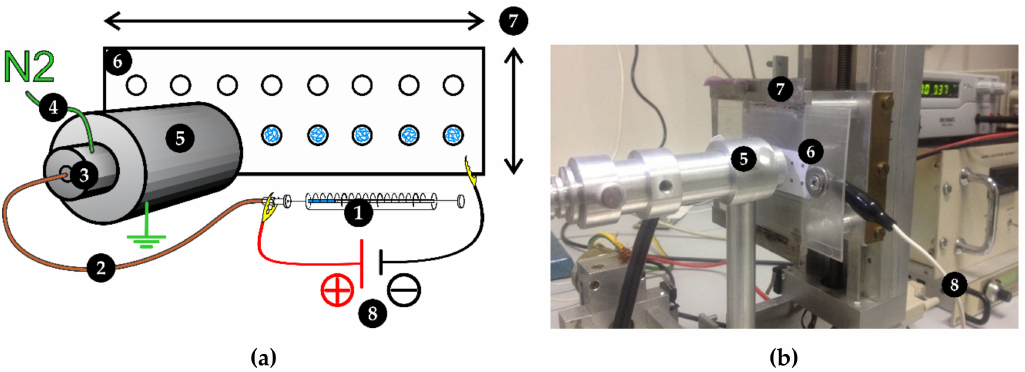
Figure 4. Schematic representation ( a ) and real-life picture ( b ) of the ambient ion-landing device. (1) linear Hamilton syringe sample loading; (2) fused silica capillary; (3) nebulizer; (4) heated nebulizing and drying gas source; (5) heated desolvation tube; (6) ITO glass MALDI-compatible support; (7) movable support holder controlled by stepper motors; (8) high-voltage power